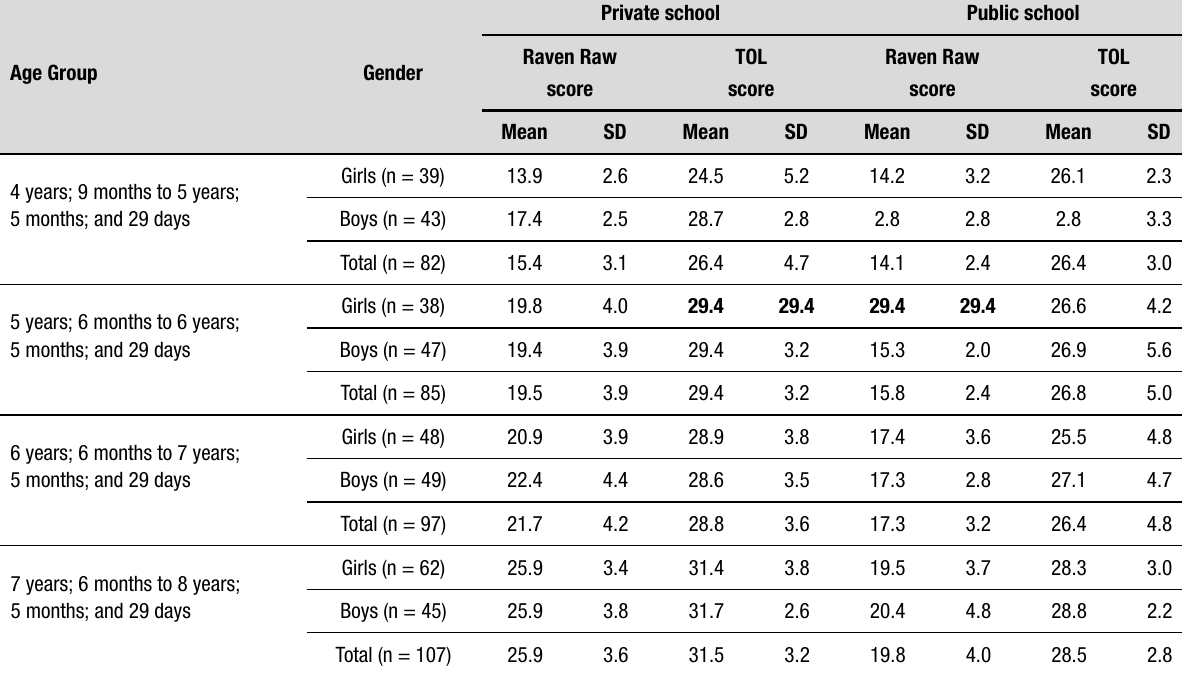
Table 2. Mean scores on the TOL and Raven tests as functions of age, gender, and type of school.